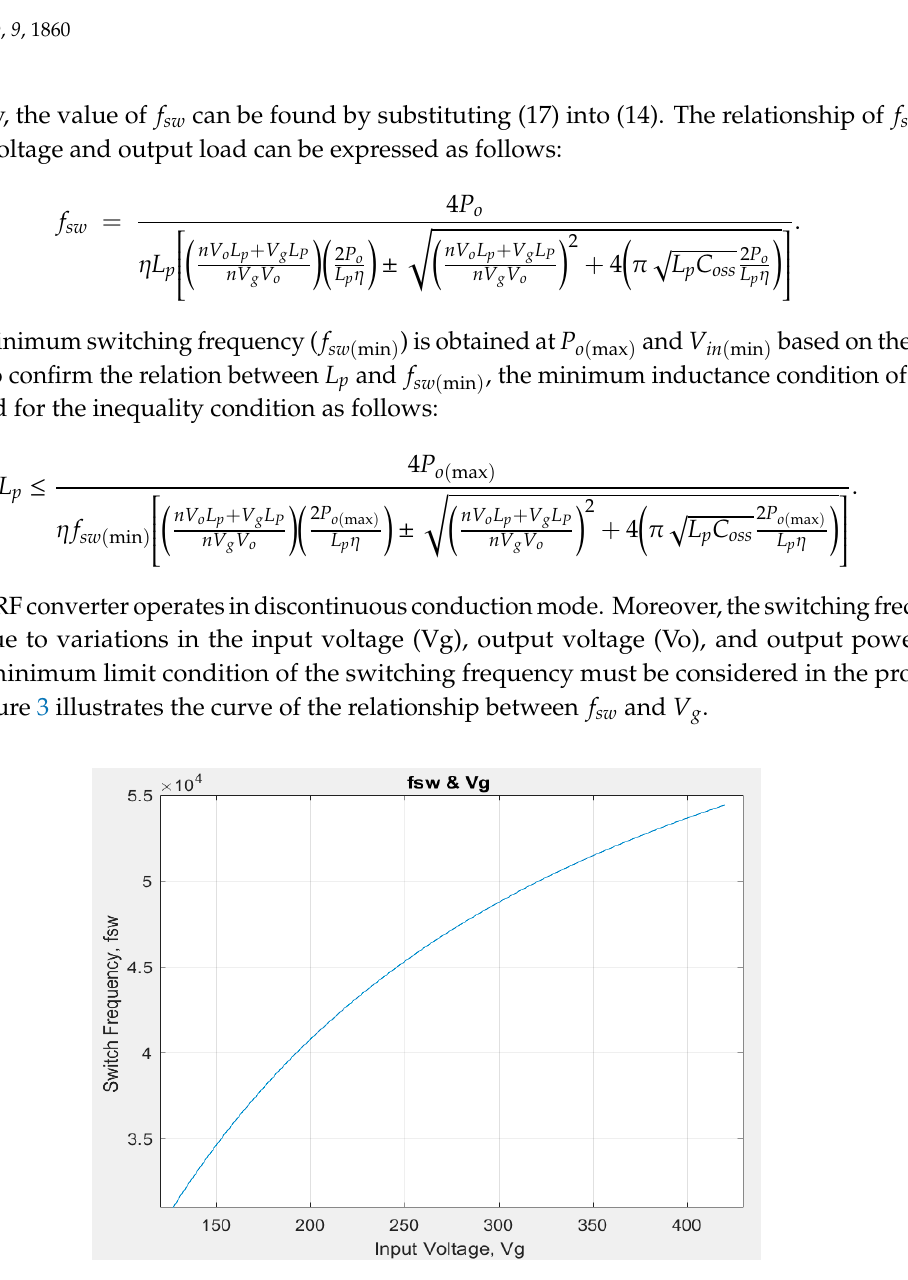
Figure 3. Curve of the relationship between f sw and V g